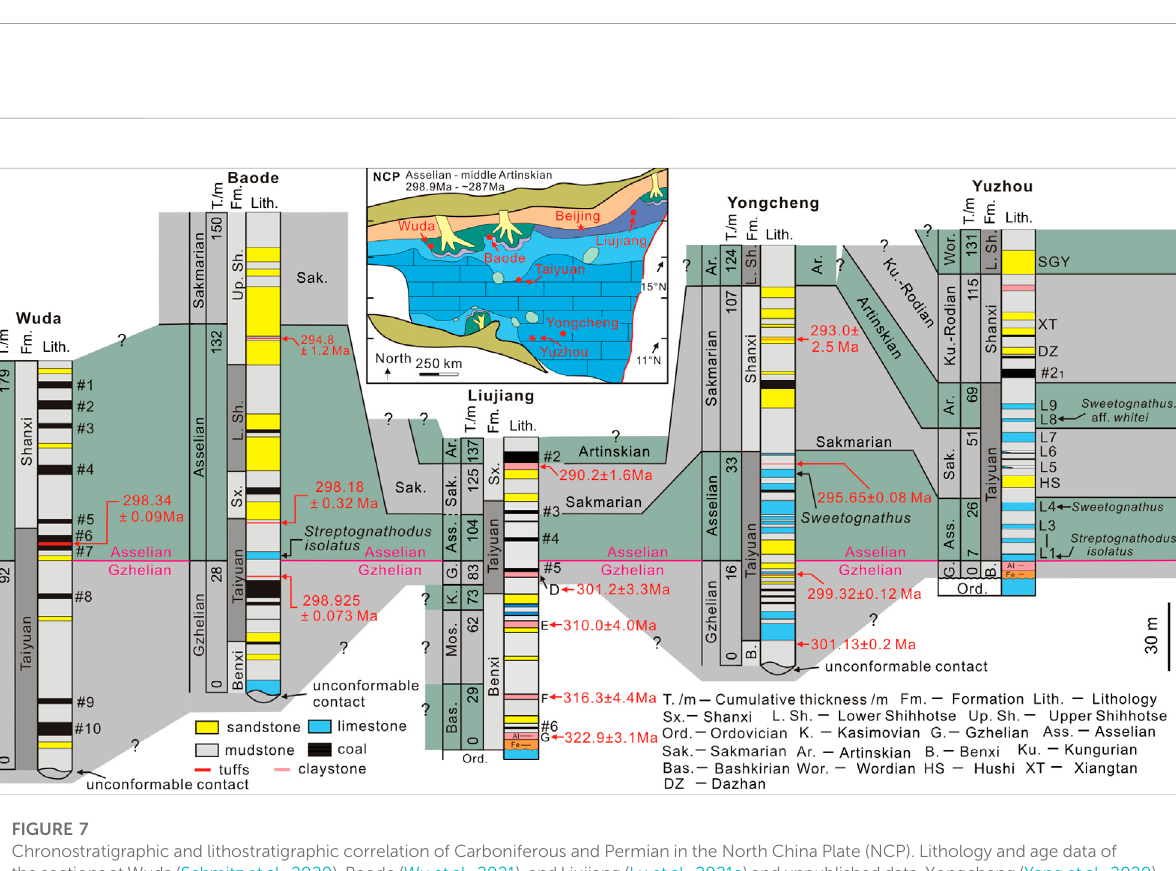
FIGURE 6 SEM images and spectra of the amorphous component of kaolinite from mudrock in the study area. (A – D) , SEM images of mudrock samples #348, #353, #363, and #375 showing kaolinite is mostly irregular fragments with sizes of 1 – 5 mm, which is distinct from authigenic kaolinite that occurs as vermiform and accordion shaped particles in the diagenetic stage, re fl ecting the detrital origin of kaolinite in the studied strata; (E – H) , spectra of the amorphous component of the kaolinite from samples #348, #353, #363, and